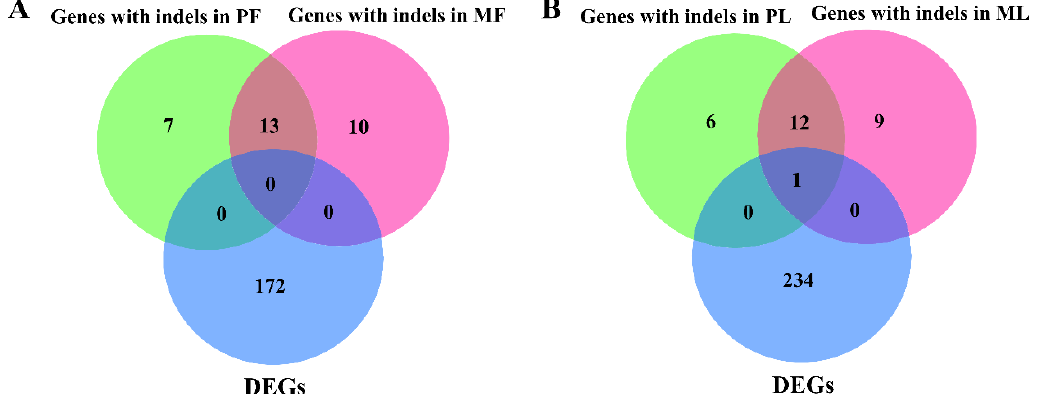
Figure 6. The identified genes with indels in PF, PL, MF and ML. ( A ) The identified genes with indels and their intersections with DEGs in PF and MF, ( B ) The identified genes with indels and their intersections with DEGs in PL and ML.